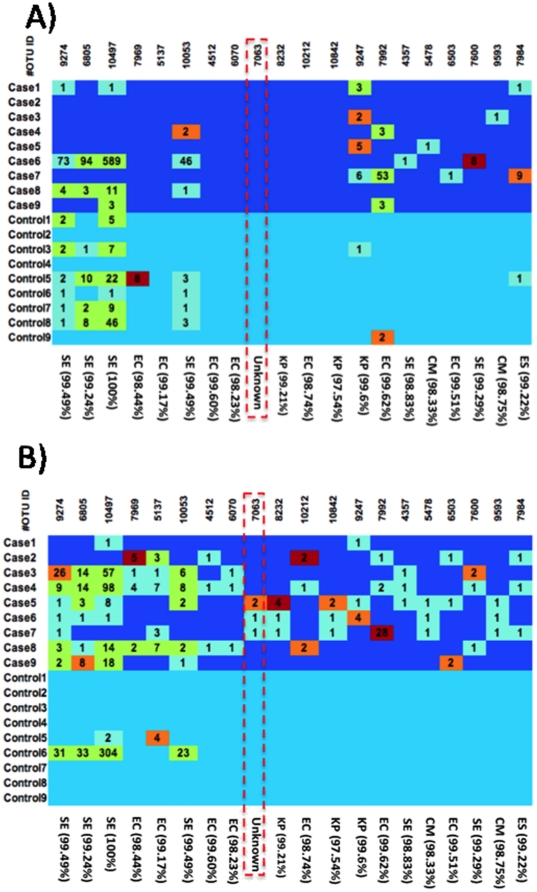
Differences in OTU abundance.Heat map of selected OTUs at 98% similarity by subject A) one week before and B) within 72 hours of NEC diagnosis. Colors indicate the ratio for a particular OTU in a sample to the average ratio of this OTU in all samples. Dark red: >10, light red: >5 and < = 10, light green: >1.5 and < = 5 and light blue: < = 1.5. Numbers indicate how often the OTU was detected. The marked Unknown OTU in B) groups closest to Klebsiella (97%) . CM: Cronobacter muytjensii; EC: Escherichia coli; ES: Enterobacter sp. glo8; KP: Klebsiella pneumoniae; SE: Staphylococcus epidermidis.